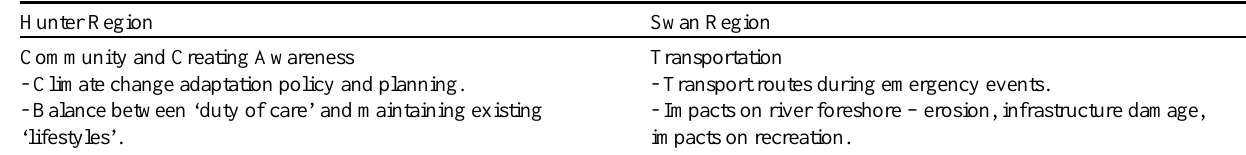
Table 2 . Important climate change issues for local government (LG) identified by focus groups. Hunter Region Swan